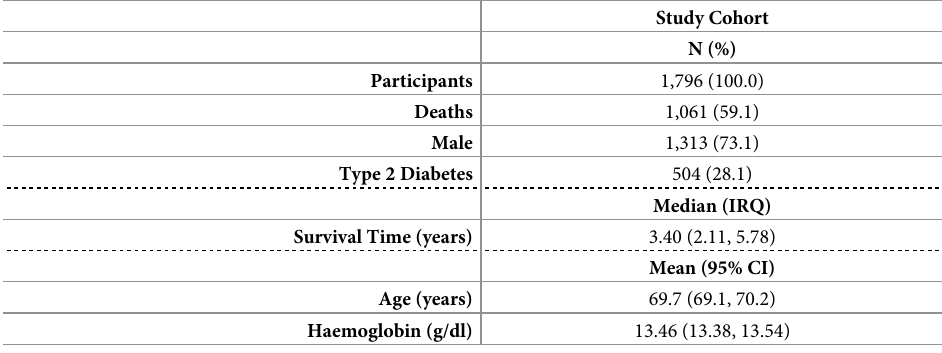
Table 1. Descriptive characteristics of the study